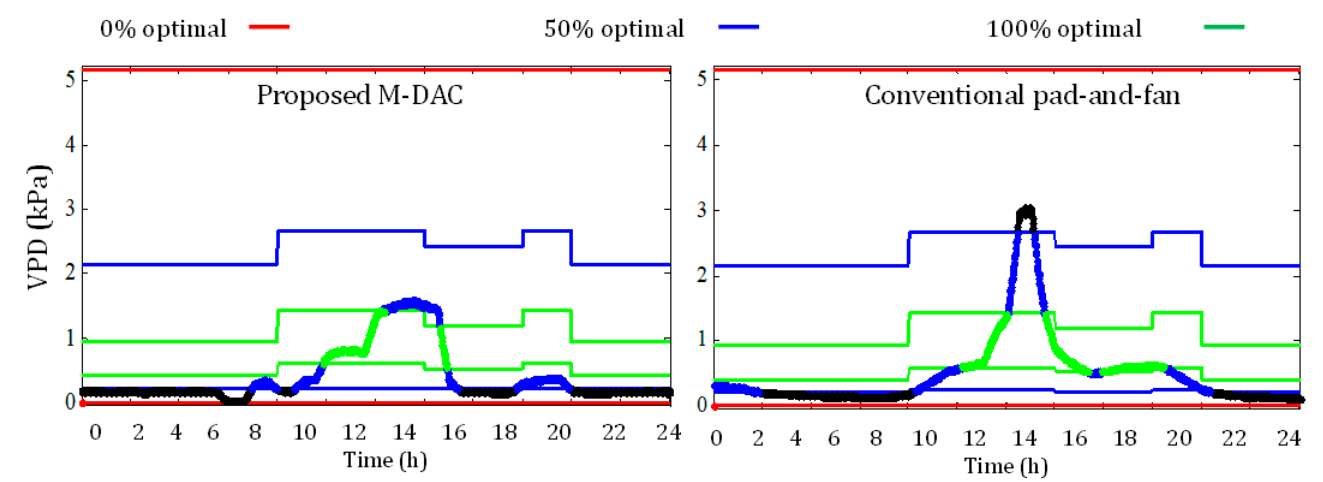
Figure 16. Comparison between comfort ratios of VPD for 24 h resulting from the proposed M-DAC system and VPD data from a conventional evaporative (pad-and-fan) cooled greenhouse. Table 3. Performance validation of the proposed M-DAC system with the comfort ratio model at α s = 1 in comparison with experimental data from a tomato greenhouse with evaporative pad-and-fan system [57] for 11 days under different growth stages.